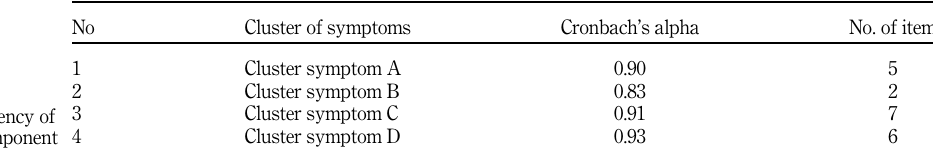
Table 2. Internal consistency of eachclustercomponent